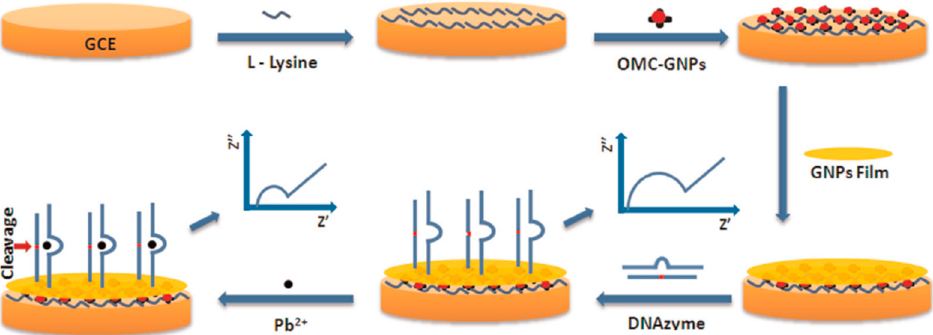
Figure 8. DNAzyme-based sensor for the impedimetric determination of Pb 2+ prepared by hybridization of DNAzyme catalytic beacons to a thiolated DNA probe self-assembled onto a GCE modified with OMC–AuNPs and an AuNPs film. Reprinted from [90] with permission.